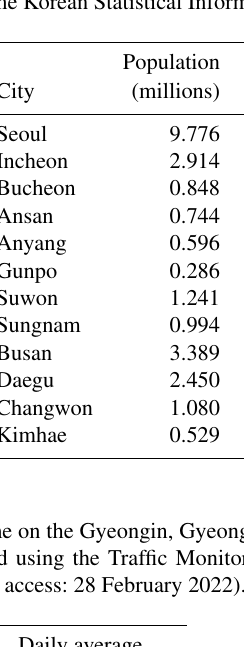
Figure 5. Tropospheric NO 2 VCD in the Seoul metropolitan region on 9 June 2016 retrieved from GeoTASO (a) at 09:00 and (b) at 15:00LT. The red boxes represent expressways (counterclockwise from left to right, (1) Gyeongin Expressway, (2) Seohaean Expressway, and (3) Gyeongbu Expressway), the orange box indicates the industrial complex, and the blue boxes indicate the major cities (Seoul, Incheon, Suwon, Bucheon, Anyang, Gunpo, Sungnam, and Ansan) of the Seoul metropolitan region. The colors of the circles depict the NO 2 surface mixing ratio obtained from Air-Korea. The colored arrows indicate the wind direction and speed at 1000hPa over the Seoul metropolitan region obtained via the Unified Model (UM) simulations (the background RGB image is from Google Earth; https://www.google.com/maps/, last access: 19 January 2023). Table 3. The population, number of registered vehicles, and average mileage per car per day of the major cities in the Seoul and Busan metropolitan region obtained from the Korean Statistical Information Service (https://kosis.kr/eng, last access: 25 March 2022).